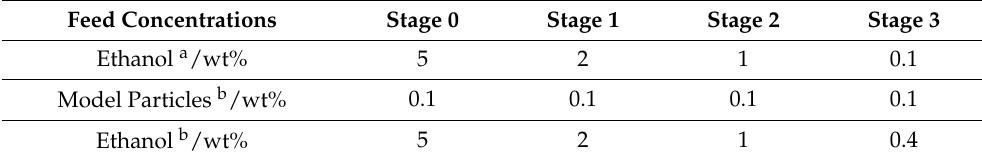
Table 4. Feed concentrations during different stages of discontinuous